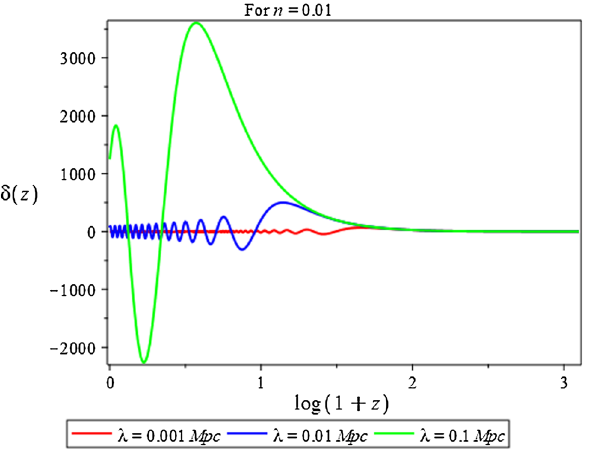
Fig. 12 δ( z ) versus z for f ( T ) = T + μ T 0 ( T / T 0 ) n for short- wavelength mode different λ at n = 0 . 01. We use Ω r = 4 . 48 × 10 − 5 for plotting